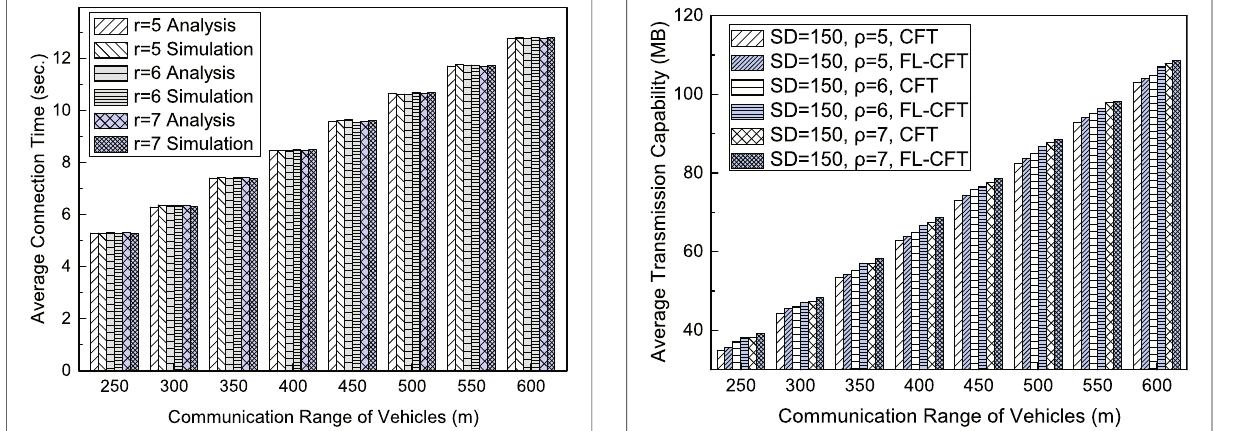
Fig. 17 Average transmission